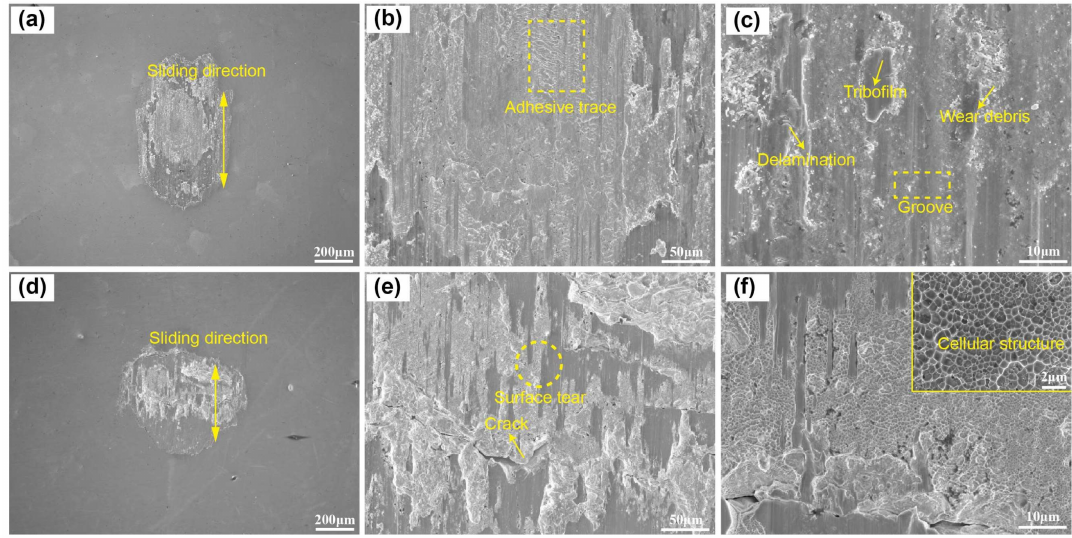
Figure 7. The SEM morphology of worn surface under LV ( a – c ) and HV ( d – f )